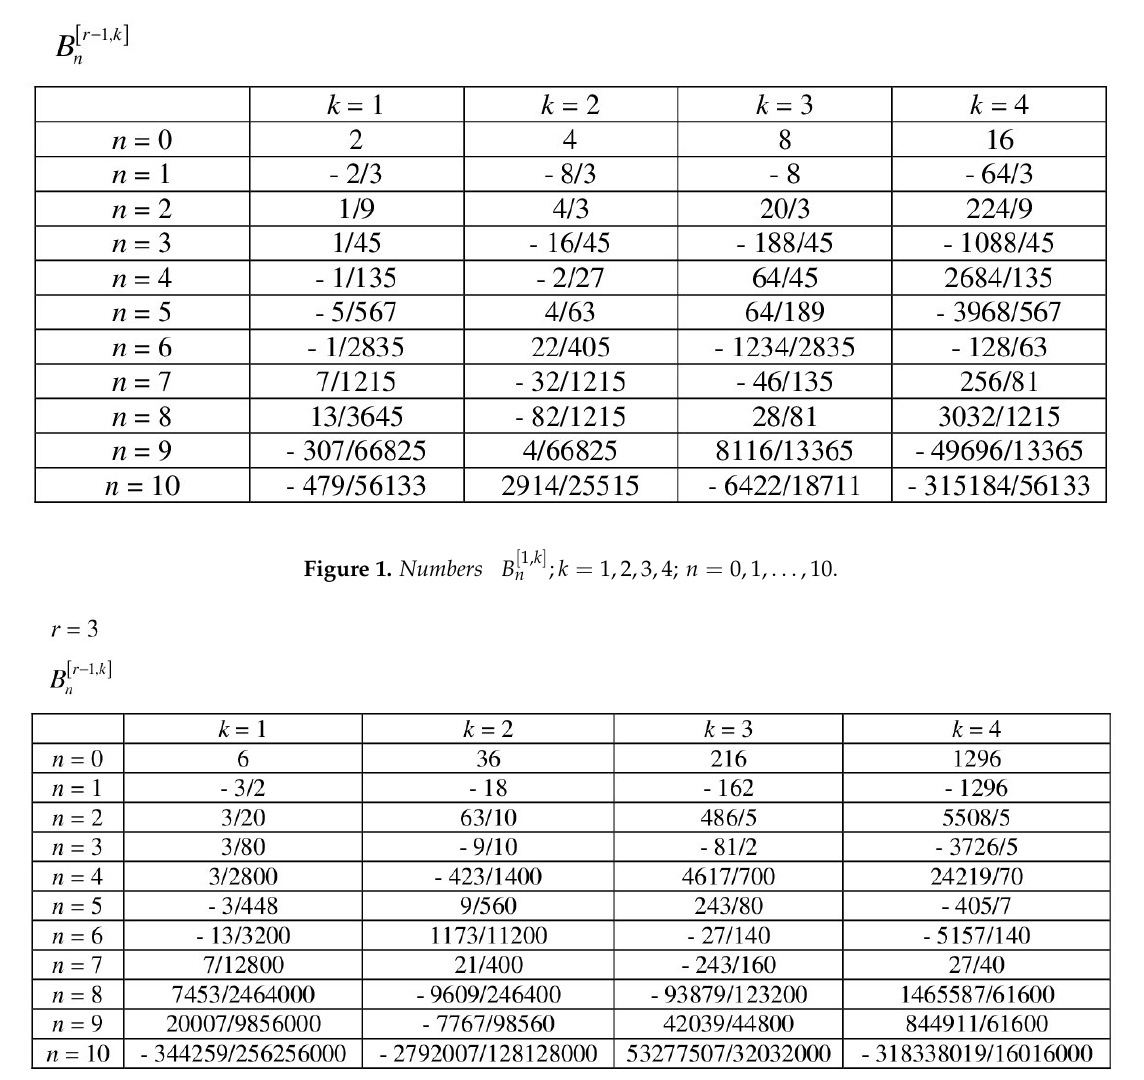
[ 2, k ] = 1,2,3,4; n = 0,1, . . . n ; k